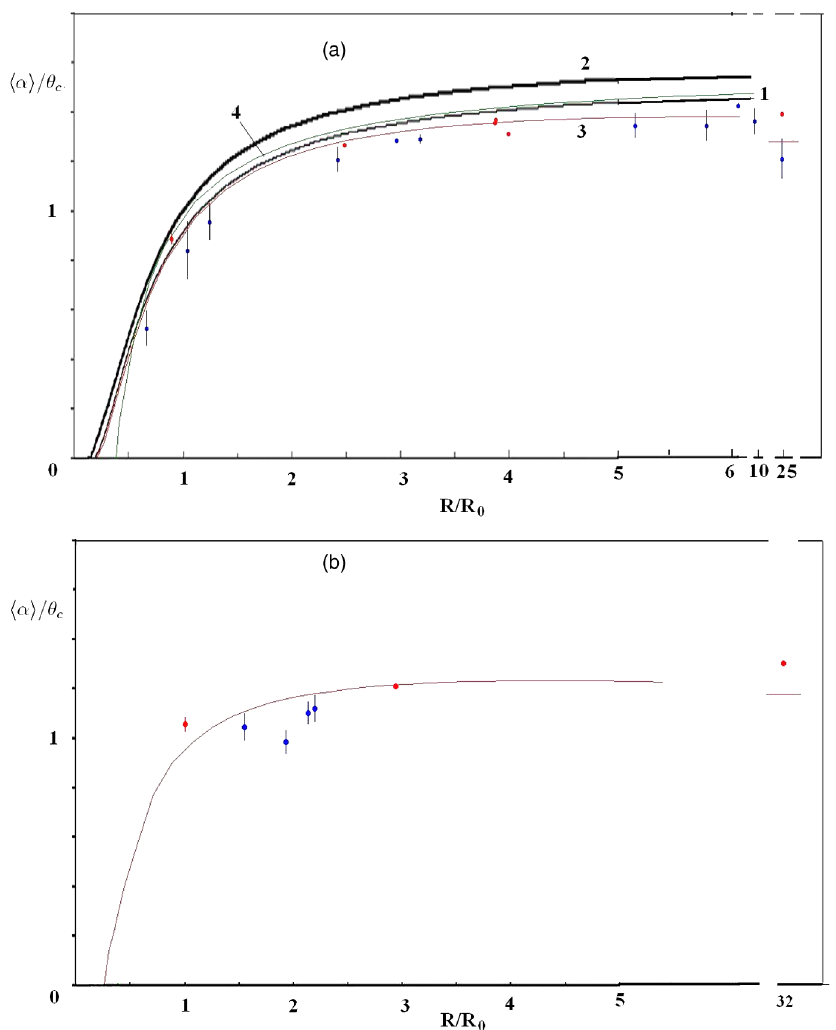
FIG. 2. Comparison between experimental and calculated mean angles of the volume reflection in the (110) (a) and (111) (b) planes of the bent silicon crystal. The red points correspond to recent measurements in Ref. [16]. For additional information, see the